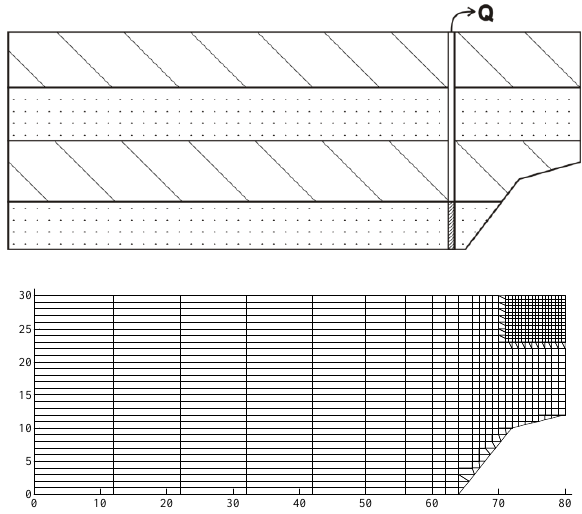
Figure 2. Conceptual model (top panel) and the finite element mesh (bottom panel) of the earth fissure